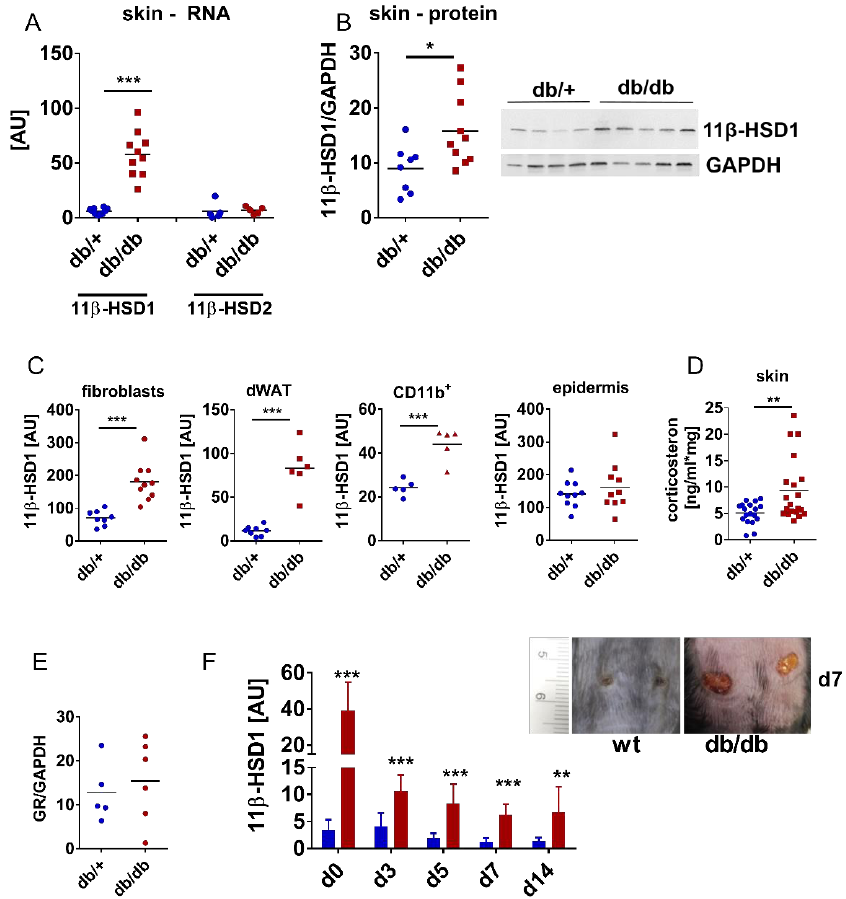
Figure 2. 11 β -HSD1 expression and corticosterone levels are increased in obese, diabetic skin. ( A – D ) In skin from db / db and control mice, 11 β -HSD1 and 11 β -HSD2 gene expressions normalised to Rplp0 were analysed by quantitative PCR ( A ), and 11 β -HSD1 protein levels were determined by western blot. Quantification was performed by densitometric evaluation, 11 β -HSD1 was normalised to GAPDH, a western blot image of 4 db /+ and 5 db / db mice, respectively, is shown ( B ), 11 β -HSD1 gene expression was analysed by quantitative PCR in skin cells and dermal adipose tissue derived from db / db mice and control mice ( C ), and corticosterone levels were analysed by ELISA ( D ). ( E ) GR protein levels were determined by western blot. Quantification was performed by densitometric evaluation, GR was normalised to GAPDH. ( F ) Full-thickness wounds were inflicted on db / db and control mice back skin. Gene expression of 11 β -HSD1 was determined by quantitative PCR during the course of wound healing, and, on day 7 after wounding, wounds were photo-documented. Each dot represents one mouse; corticosterone levels were determined in duplicates. Unpaired t -test, * p < 0.05, ** p < 0.01, *** p < 0.001. AU, arbitrary units; dWAT, dermal white adipose tissue; epi, epidermis; FB, fibroblasts; GR, glucocorticoid receptor; wt,